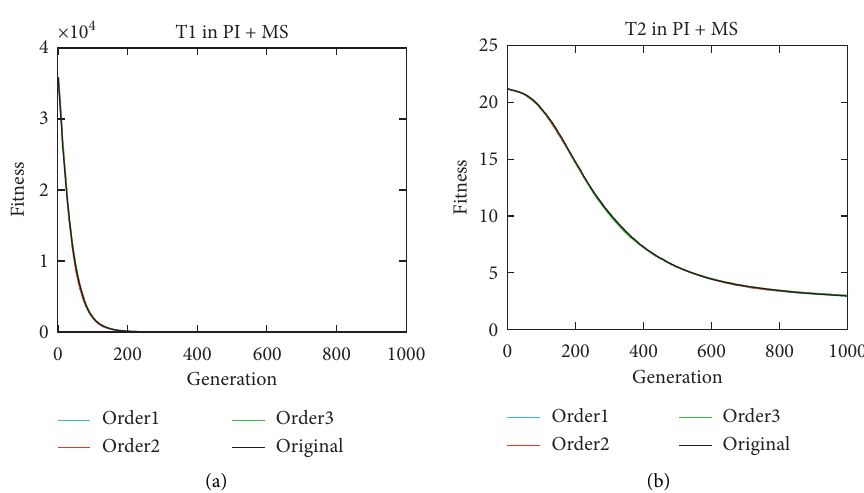
Figure 8: Convergence of MFEA for problem 5